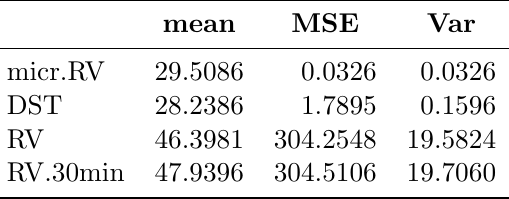
Table 5: Simulation 5. Constant instantaneous volatility and p (1) = − 0 . 36 , p (2) = 0 . 124 with noise to signal ratio 0.92. Annualised volatility: